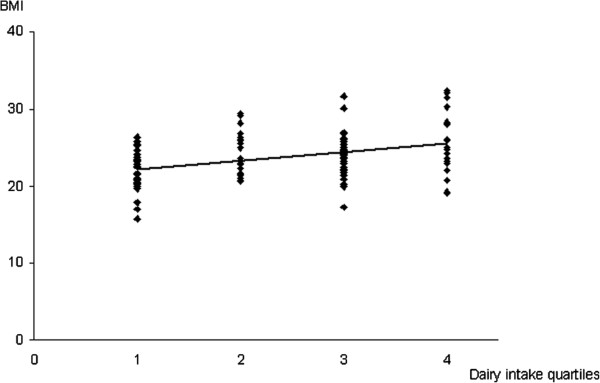
Correlation between BMI and dairy intake quartiles (times/week). The figure shows the significant Spearman’s correlation between BMI values and dairy intake quartiles (1: ≤8, 2: 9–10, 3: 11–14, and 4: ≥15) in the HIV-infected subjects (ρ = 0.36; P < 0.0001).